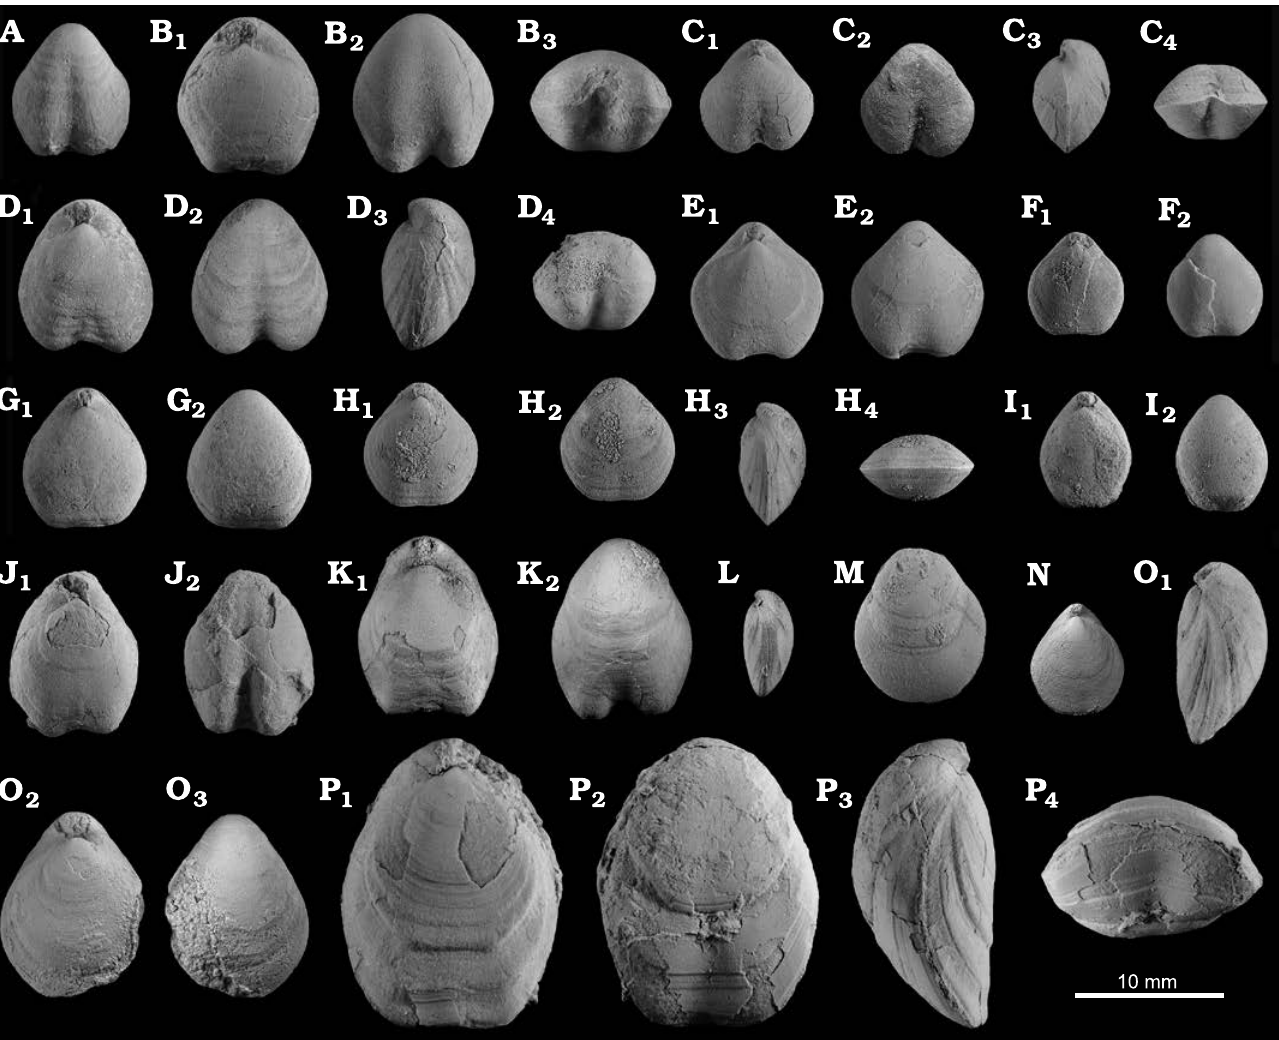
Fig. 17. Terebratulida from the Brigantian (uppermost Visean) of Ricklow Quarry, near Monyash, Derbyshire, UK (localities RCC-, RCK-; Fig. 3). A – K . Harttella oakleyi Brunton, 1982. A . MPUM12075 (RCC10-15b) in ventral view. B . MPUM12076 (RCC41-9) in dorsal (B 1 ), ventral (B 2 ), and ante- rior (B 3 ) views. C . MPUM12077 (RCC41-22) in dorsal (C 1 ), ventral (C 2 ), lateral (C 3 ), and anterior (C 4 ) views. D . MPUM12078 (RCC49-9) in dorsal (D 1 ), ventral (D 2 ), lateral (D 3 ), and anterior (D 4 ) views. E . MPUM12080 (RCC60-19b) in dorsal (E 1 ) and ventral (E 2 ) views. F . MPUM12079 (RCC49-12) in dorsal (F 1 ), and ventral (F 2 ) views. G . MPUM12081 (RCC65G-2) in dorsal (G 1 ) and ventral (G 2 ) views. H . MPUM12082 (RCC65G-8a) ) in dorsal (H 1 ), ventral (H 2 ), lateral (H 3 ), and anterior (H 4 ) views. I . MPUM12083 (RCC65G-11) in dorsal (I 1 ) and ventral (I 2 ) views. J . MPUM12084 (RCC65G-14) in dorsal (J 1 ) and ventral (J 2 ) views. K . MPUM12085 (RCK15-14) in dorsal (K 1 ) and ventral (K 2 ) views. L – O . ? Balanoconcha sp. L . MPUM12094 (RCC10- 15a) in lateral view. M . MPUM12095 (RCC300-1) in ventral view. N . MPUM12097 (RCK15-26) in dorsal view. O . MPUM12096 (RCK15-18) in lateral (O 1 ), dorsal (O 2 ), and ventral (O 3 ) views. P . Beecheria sp., MPUM12092 (RCC49-31) in dorsal (P 1 ), ventral (P 2 ), lateral (P 3 ), and anterior (P 4 )